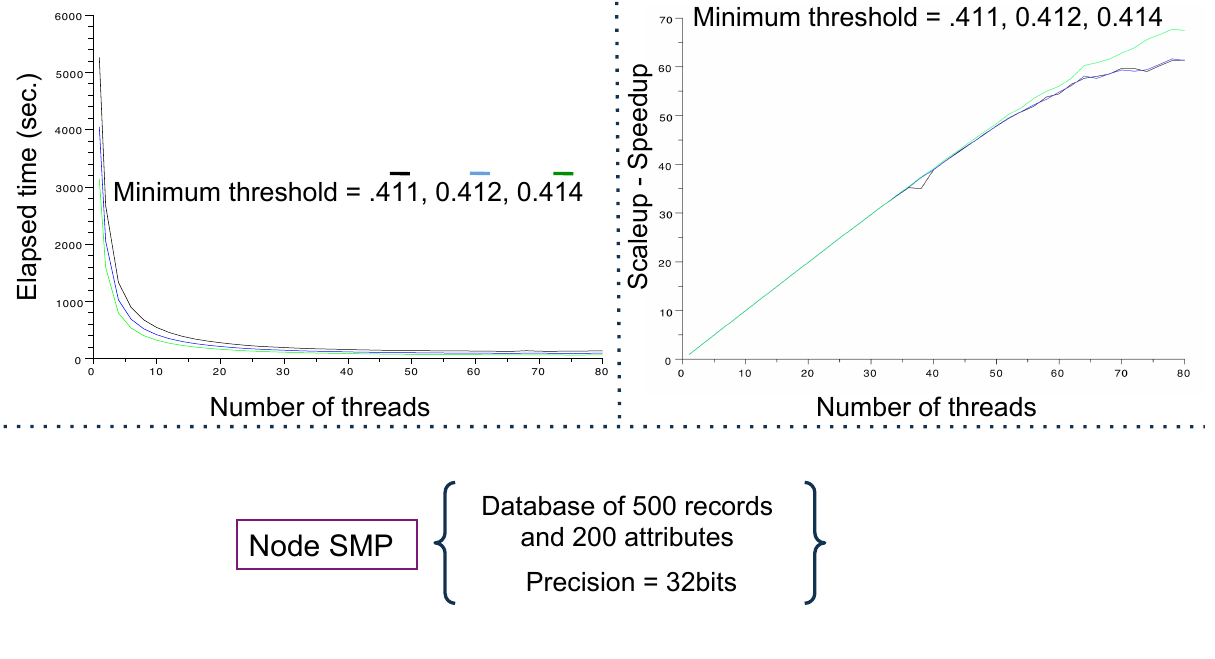
Figure 8. Execution time and Speedup related to the number of threads on SMP nodes for synthetic database of 200 attributes at precision 32 bits with minimum threshold values 0.411, 0.412, 0.414.